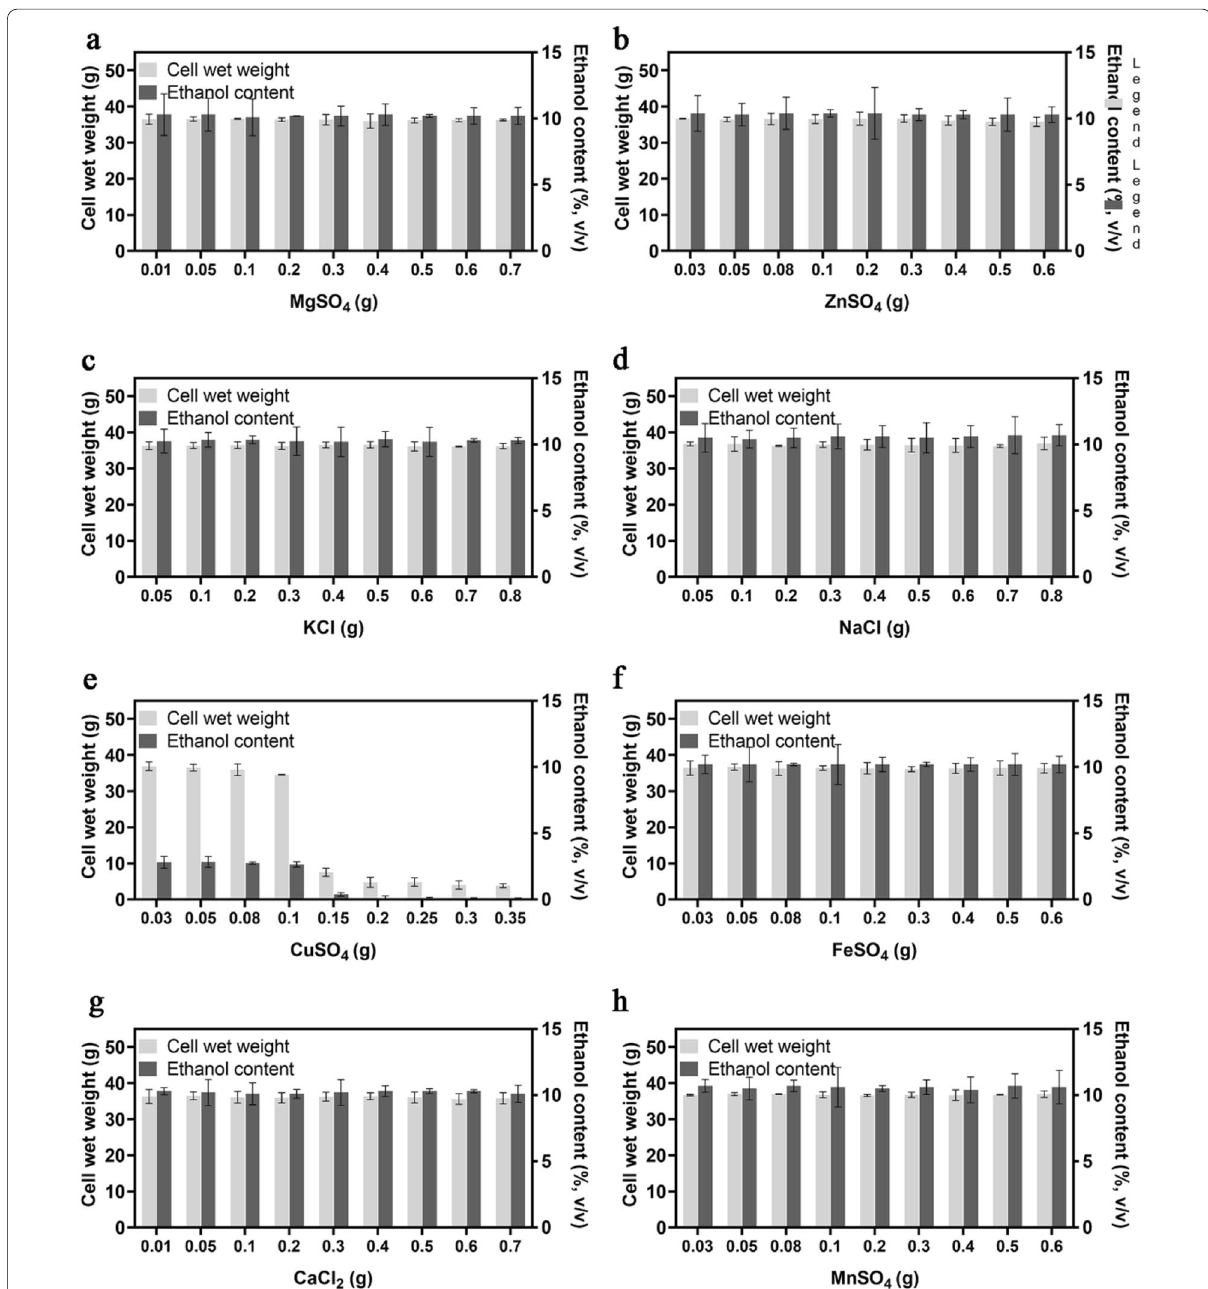
Fig. 5 Effect of metal ions on the cell wet weight and ethanol content of glucoamylase expressing strain CIBTS1522. The influence of MgSO 4 ( a ), ZnSO 4 ( b ), KCl ( c ), NaCl ( d ), FeSO 4 ( e ), CuSO 4 ( f ), CaCl 2 ( g ), and MnSO 4 ( h ) were shown. Error bars represent the standard deviation from the mean of three